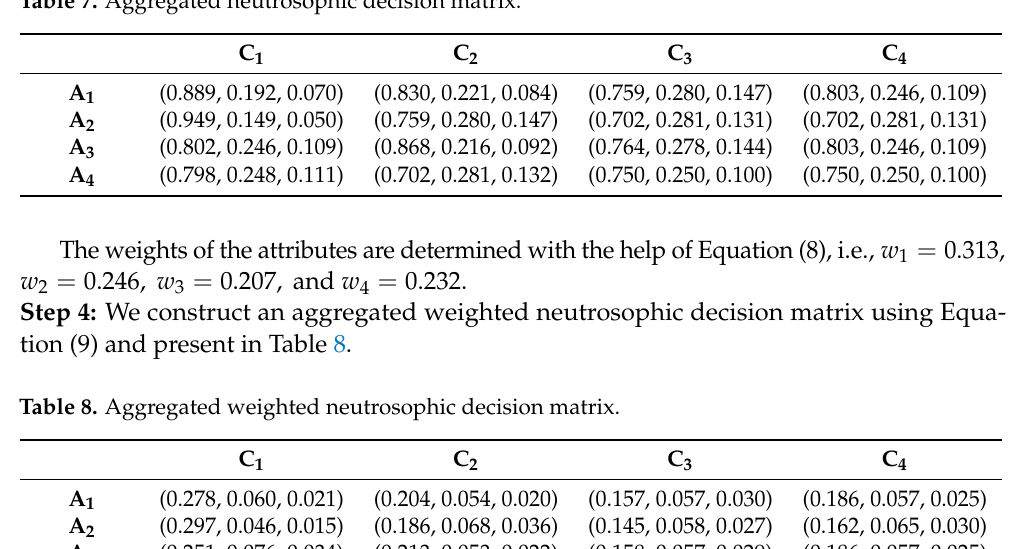
Table 7. Aggregated neutrosophic decision matrix.